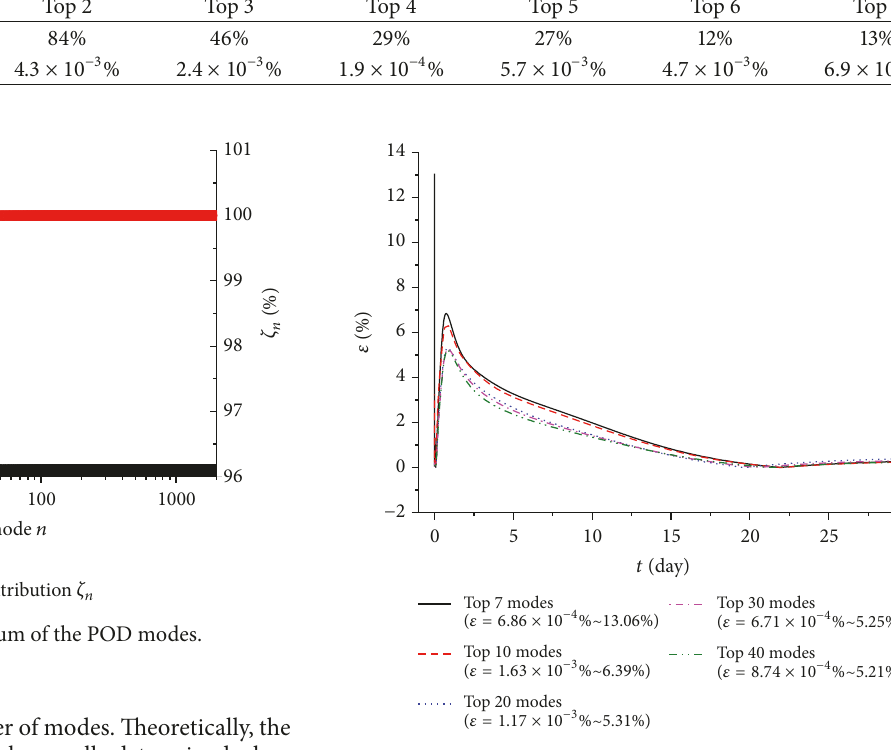
Figure 3: Reconstruction deviations using different numbers of POD